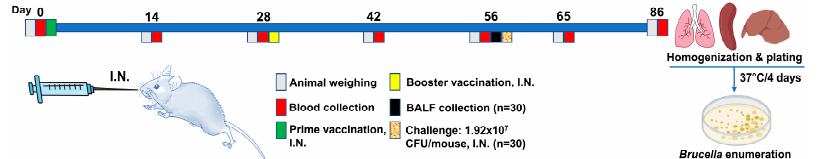
Figure 1. Chart showing the experimental details used in this study. Sixty BALB/C mice were vaccinated at 0 and 28 days. Blood collection was performed using the Lancet method at all the indicated time points except at necropsy day, where cardiac puncture was used. On day 56, BALF samples were collected from 30 mice and the rest of the animals were challenged intranasally using B. abortus S19 at 1.92 × 10 7 CFU/mouse before termination of the study on day 86. Different organs were sampled, homogenized, ten-fold serially diluted, and plated on Brucella selective agar. CFUs were enumerated at day 4 postincubation at 37 °C in a CO 2 incubator. This chart was created by powerpoint using images and cartoons obtained from clipart-library.com and biorender.com.